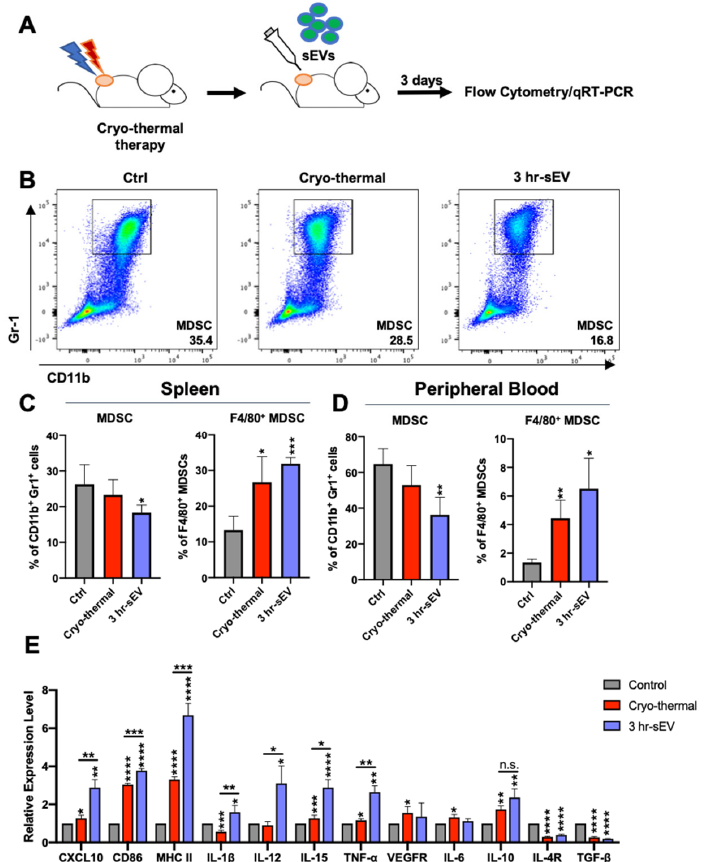
Figure 3. Supplement of sEVs after cryo-thermal therapy promoted the differentiation of MDSCs and monocytes to macrophages in PBMCs. ( A ) Schematic of experimental design; 50 µ g of sEVs was injected into mice immediately after cryo-thermal therapy via the tail vein; 3 days later, splenocytes and PBMCs were isolated and characterized by using flow cytometry. ( B ) Flow cytometry gating strategy for determination of CD11b + Gr1 + MDSCs. ( C , D ) Proportions of MDSCs and F4/80 + MDSCs in spleen ( C ) and peripheral blood ( D ) were detected by flow cytometry, and the Student’s t -test was used for statistical analysis ( n = 4 per group). ( E ) Immune-related molecules of MDSCs were examined by qRT-PCR on day 3 after cryo-thermal therapy and sEV injection ( n = 4 per group). Data were shown as mean ± SD. * p < 0.05, ** p < 0.01, *** p < 0.001, **** p < 0.0001 by one-way